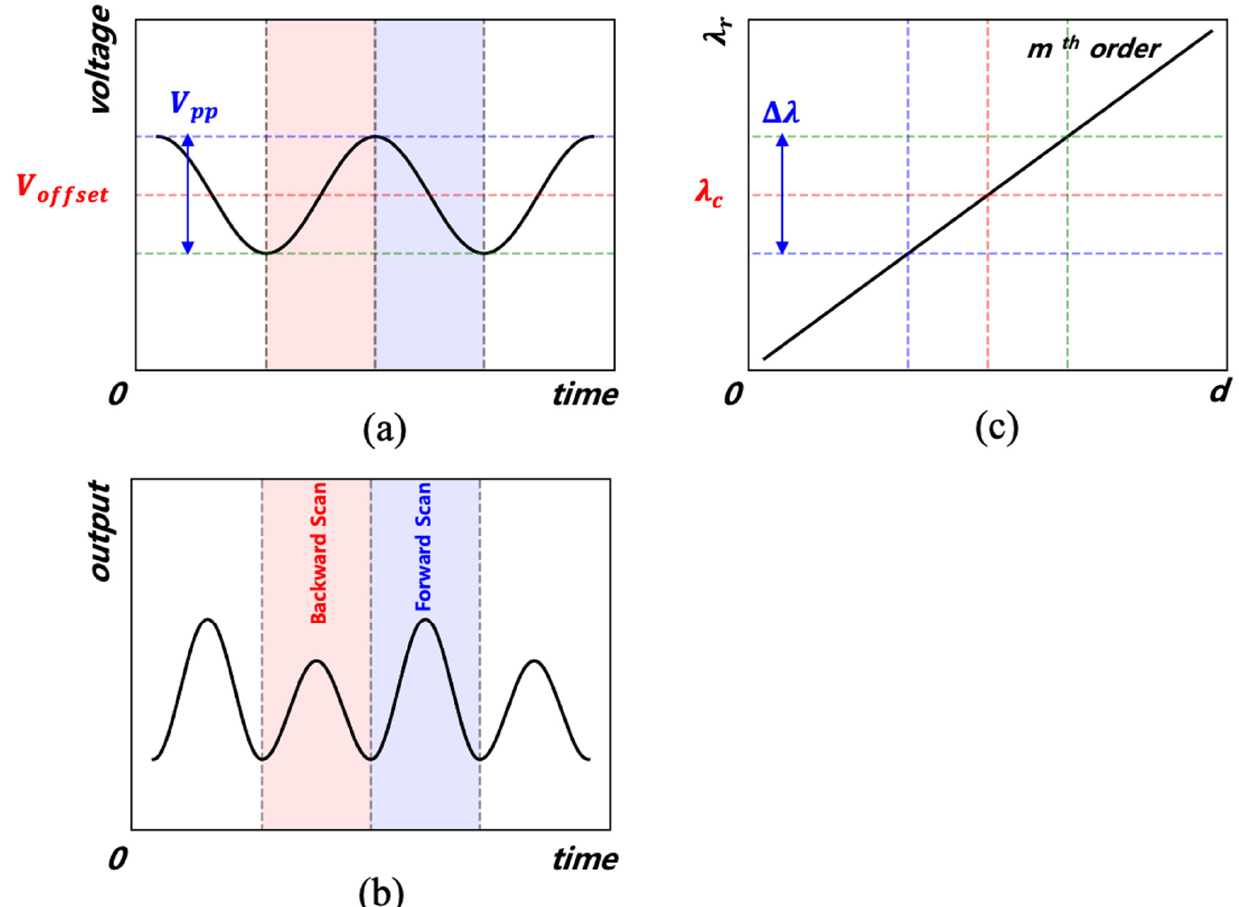
Figure 1. ( a ) Applied voltage of a fiber Fabry–Pérot tunable filter (FFP-TF), ( b ) output of a wavelength-swept laser (WSL) in the temporal domain, and ( c ) the resonant wavelength of a FFP-TF. In this study, the peaks of the forward and backward scans were measured by a PD and displayed on an oscilloscope. An electrical signal is directed back to the FFP-TF to adjust the applied offset voltage. By appropriately adjusting the offset and peak-to-peak voltages applied to the FFP-TF, the WSL peak wavelength can be positioned at the point of maximum laser resonator gain. By measuring the WSL intensity in the temporal domain, the largest value can be obtained at the peak